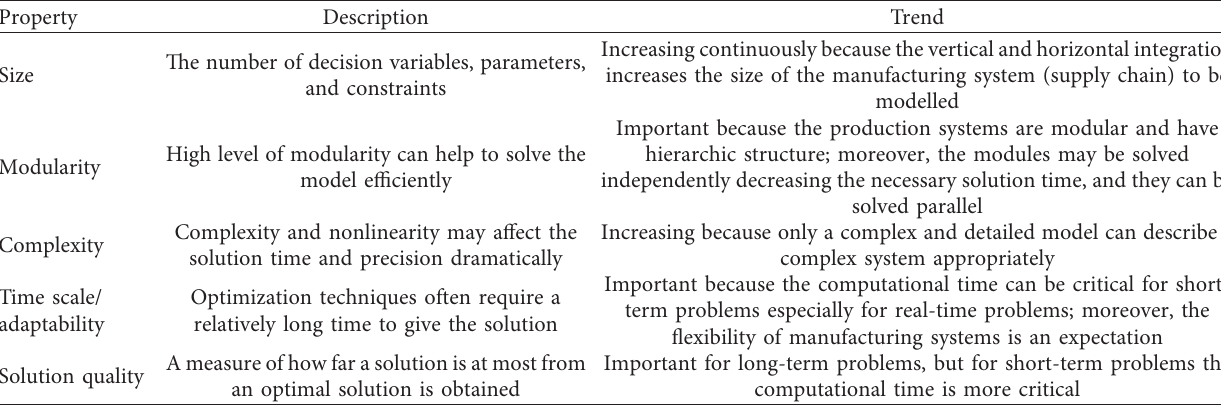
Table 7: Typical characteristics of classical optimization